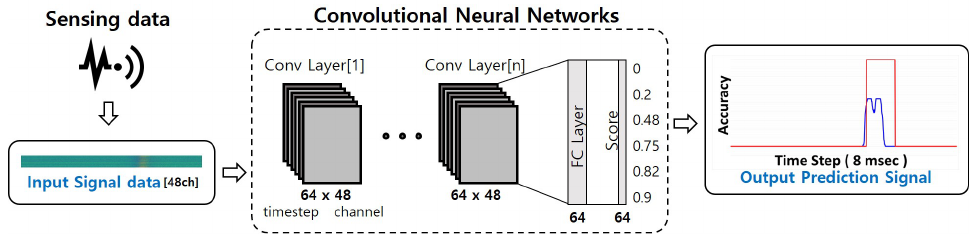
Figure 7. Signal learning with convolution neural networks architecture.